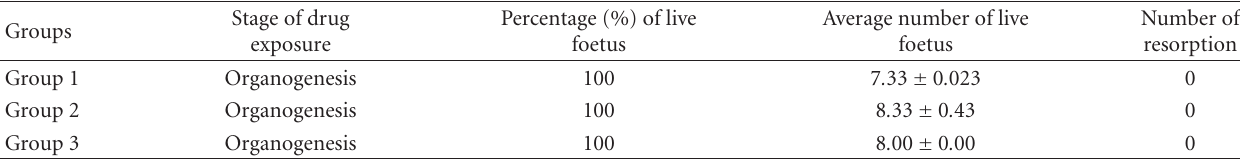
Table 1: Incidence of resorption and live foetus in treated rats.